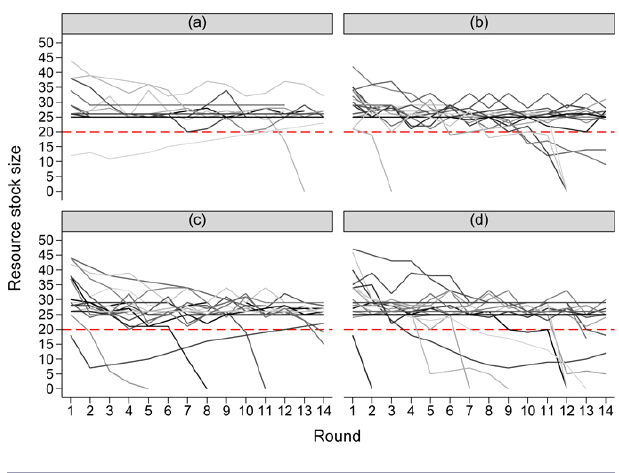
Fig. 2 . Time series of resource stock size after group harvest and before growth for the threshold treatment (a), high-risk treatment (b), medium-risk treatment (c) and low-risk treatment (d). Data points below the red dashed line (potential threshold) indicate severe overexploitation, i.e., crossing of the potential threshold. Note that a group that crossed the potential threshold and depleted the resource stock in the same round was not classified as a group that severely overexploited the resource. Bear in mind also that these graphs do not say anything about whether the groups that crossed the potential threshold actually played scenario B. Some groups in the threshold treatment followed the exact same strategy, and this is why there appear to be fewer than 20 time series in graph (a). Four groups in graph (a) and one group in graph (d) played fewer than 14 rounds; therefore the time series stops earlier.